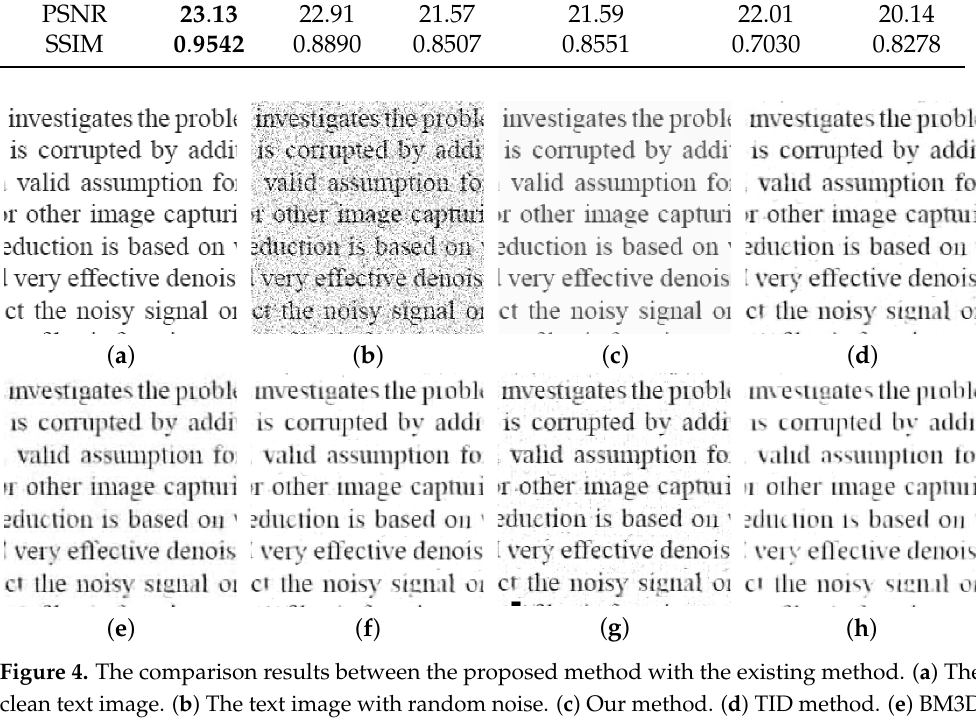
Figure 4. The comparison results between the proposed method with the existing method. ( a ) The clean text image. ( b ) The text image with random noise. ( c ) Our method. ( d ) TID method. ( e ) BM3D method. ( f ) BM3DPCA method. ( g ) LPG–PCA method. ( h ) NLM method.